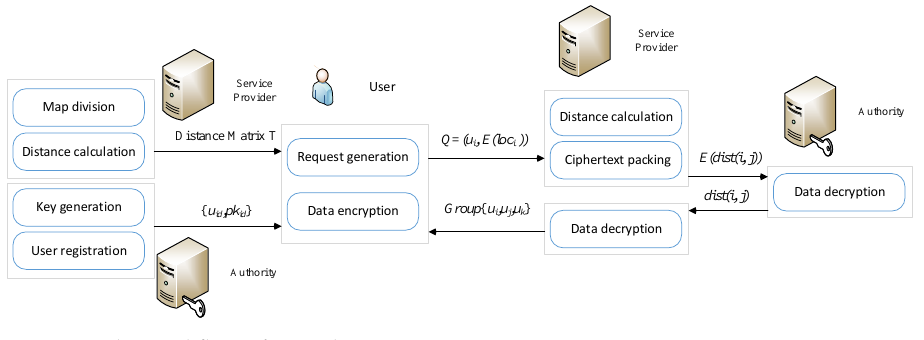
Figure 3. The workflow of our